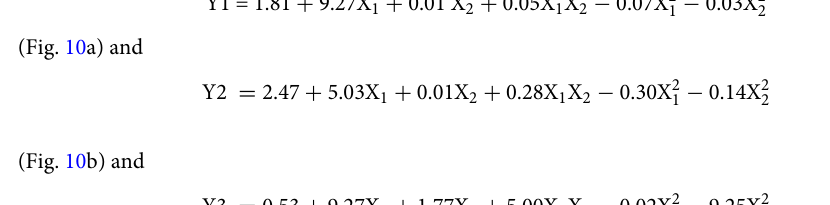
(Fig. 10c). The prediction results of the model showed that the best quality of Chinese chive (1.84 mg kg −1 soluble protein, 2.46 OD 325 g flavonoids, and 0.53 OD 280 g total phenol) could be obtained when the contents of available P and total P in greenhouse soil were 125.07 mg kg −1 and 1.26 g kg −1 , respectively. The results show